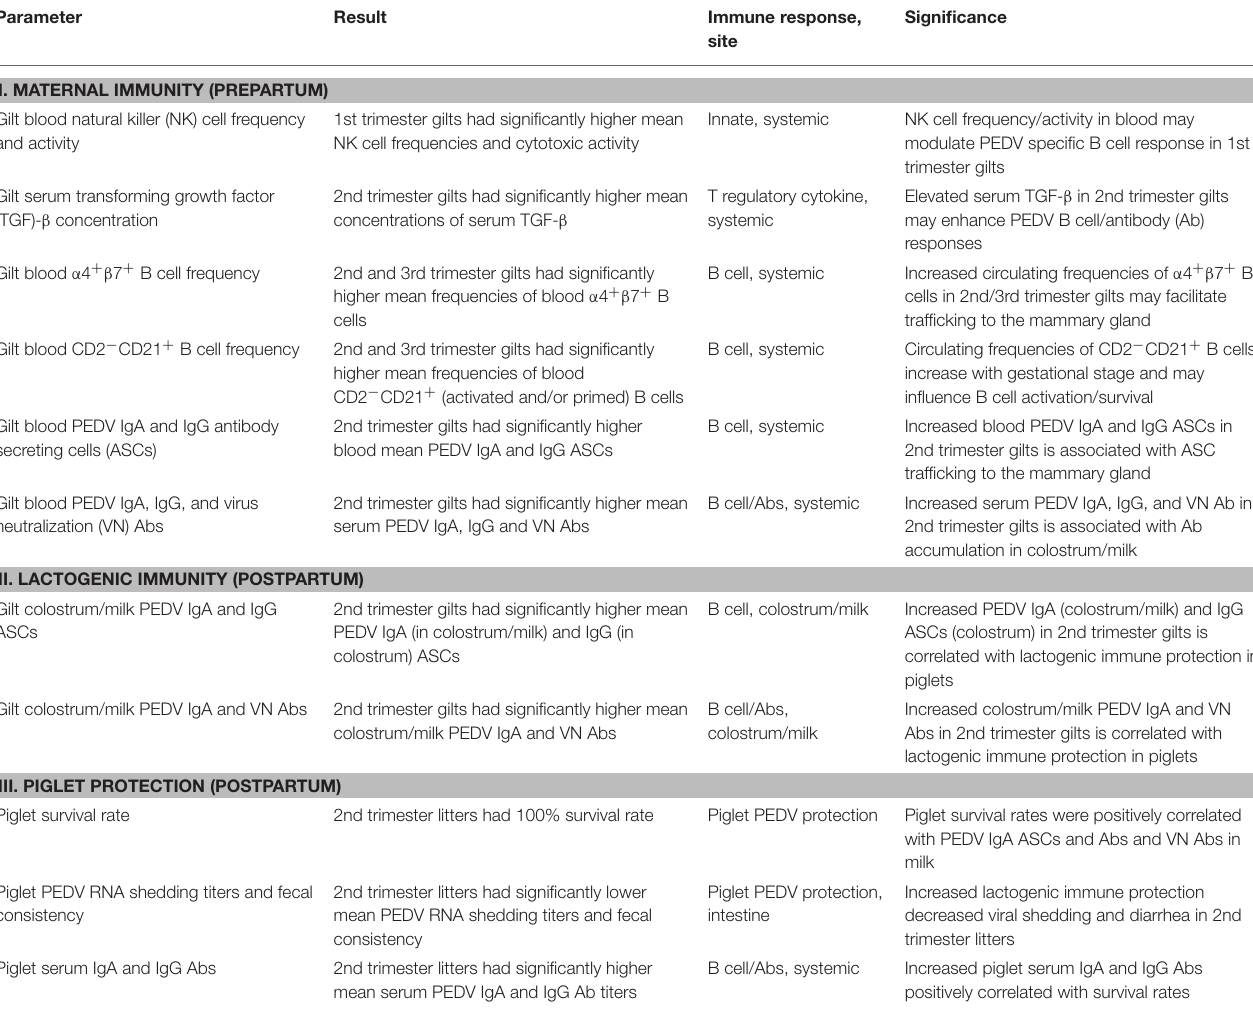
TABLE 1 | Overall summary of results and significance for the major immune and PEDV protection parameters